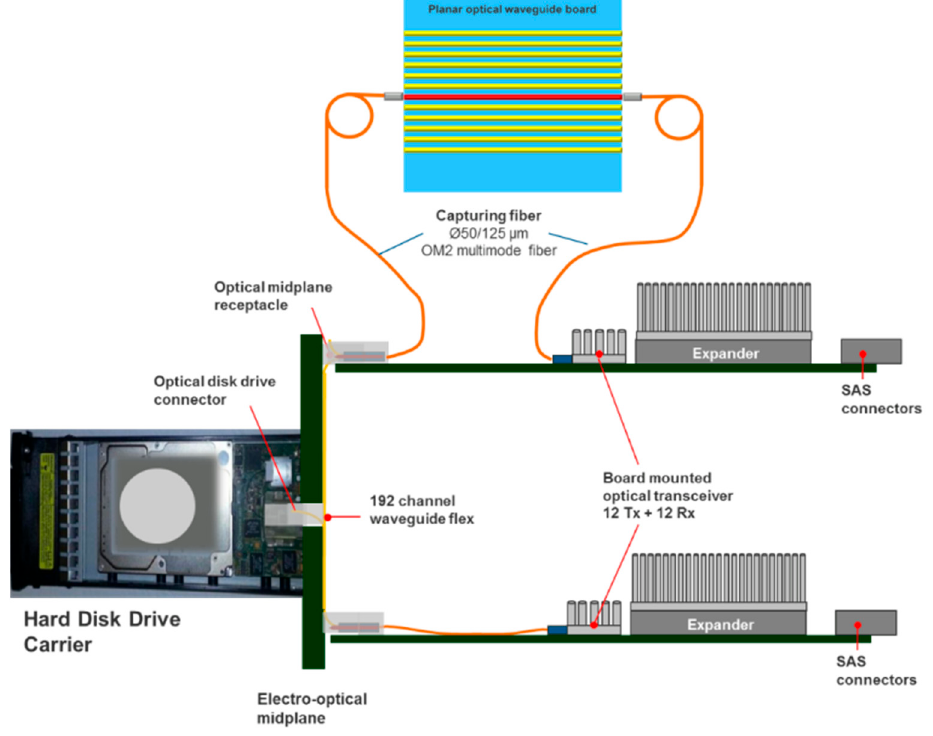
Figure 18. System level measurement set-up showing the optically enabled system schematic with waveguides under test connected to the intra-system optical network.